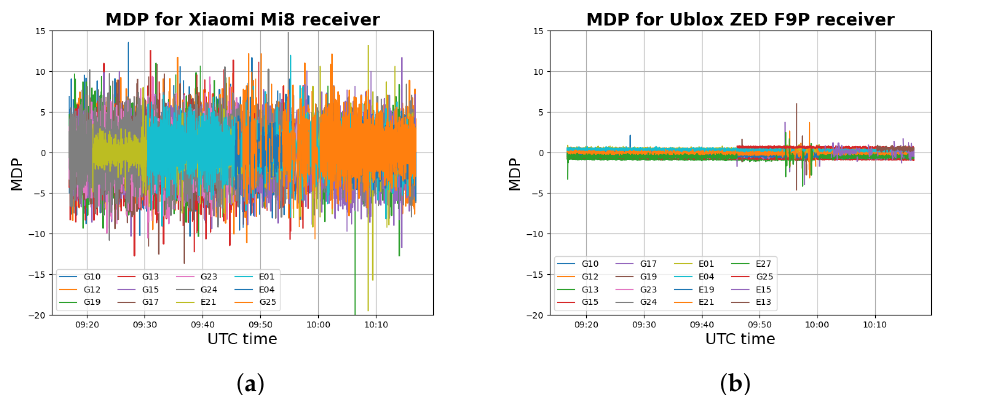
Figure 9. MDP values for Xiaomi Mi8 receiver ( a ) and for Ublox ZED F9P receiver ( b ) for the static data